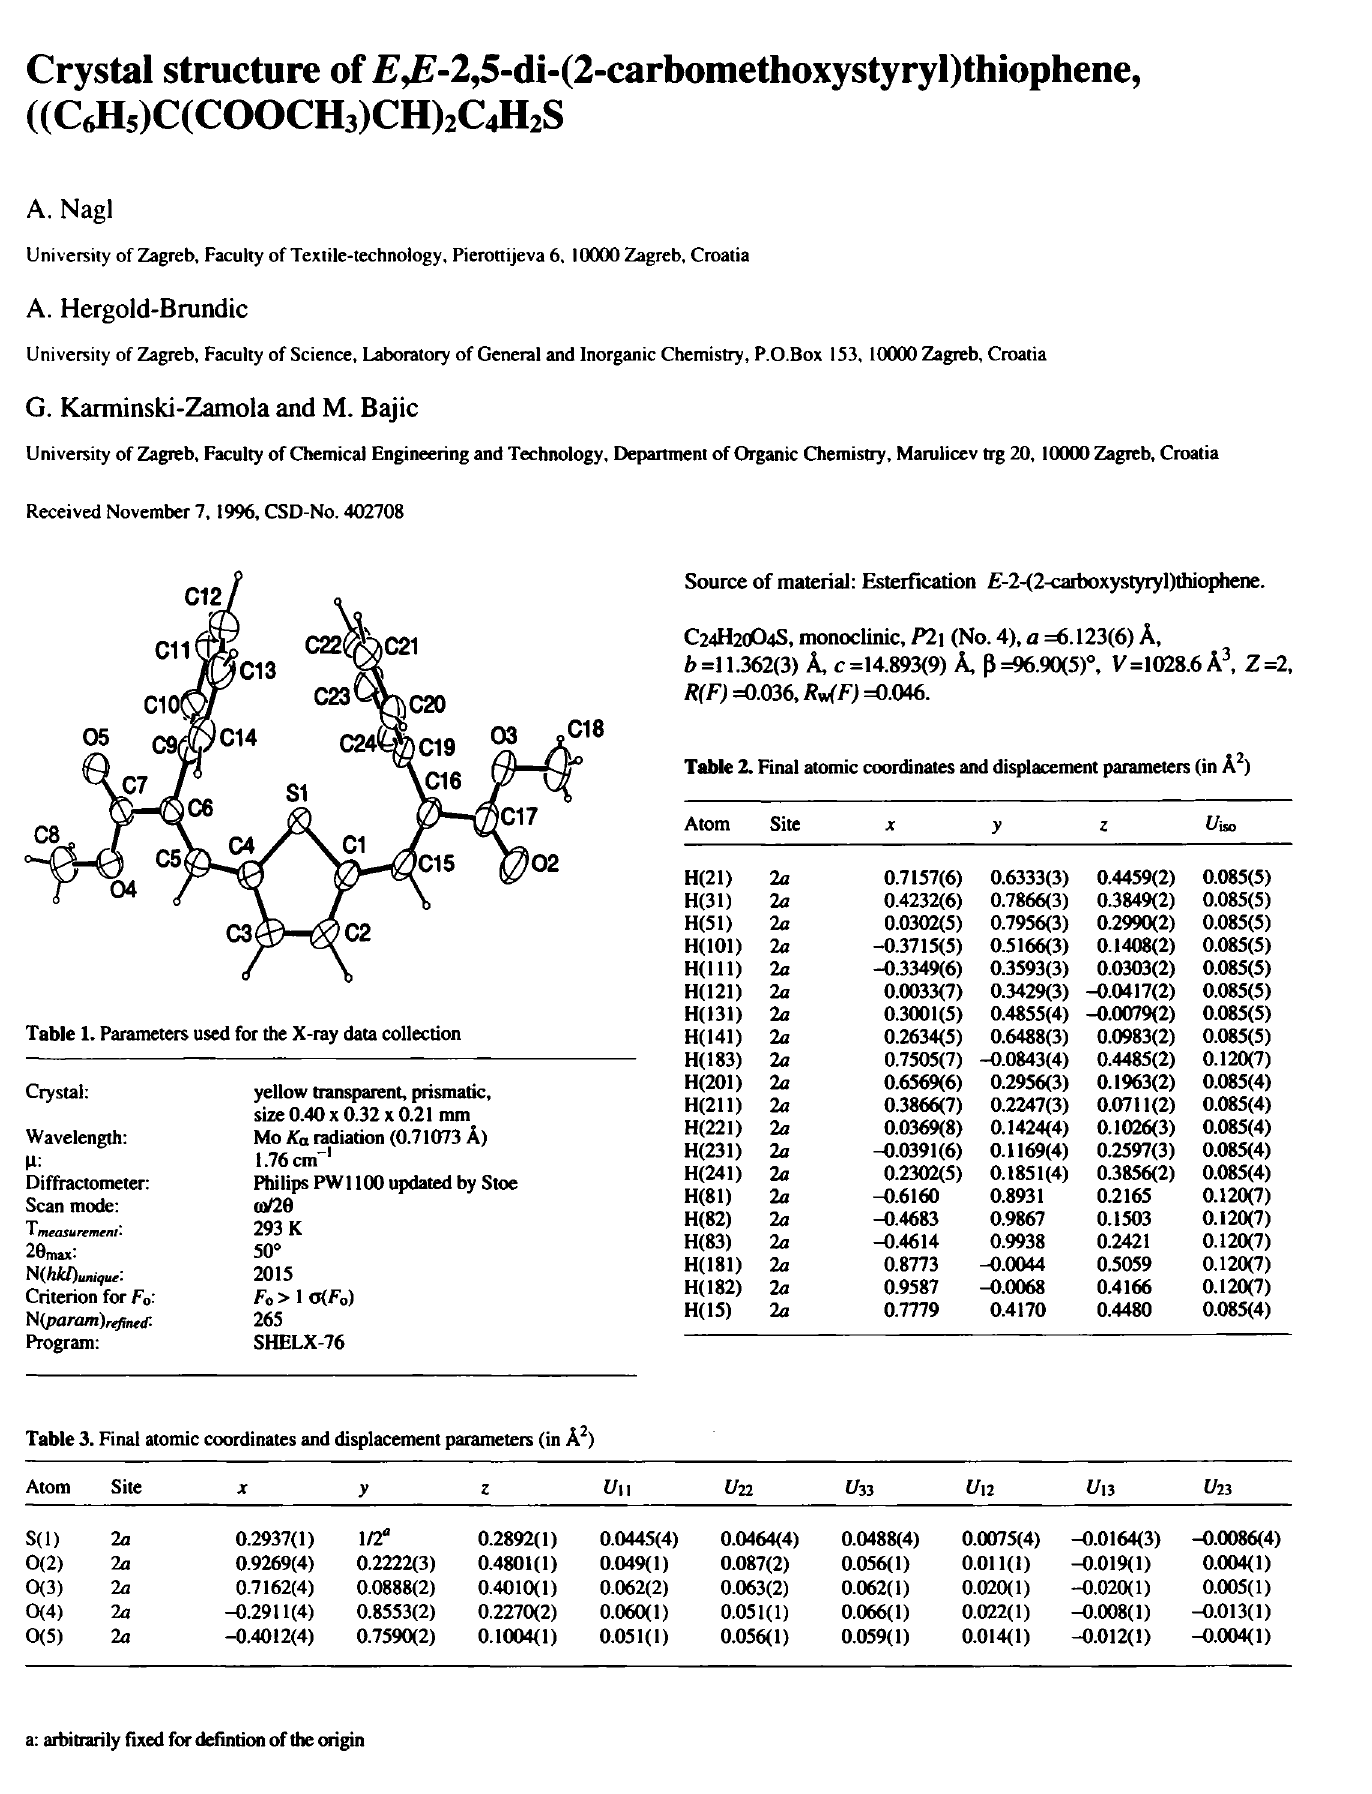
Table 1. Parameters used for the X-ray data collection Crystal: